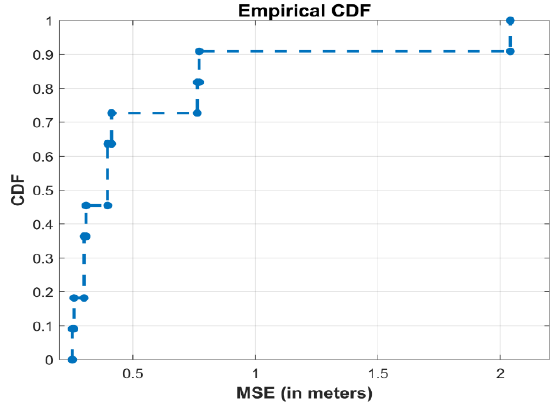
Figure 4. CDF of localization error for the DE algorithm.